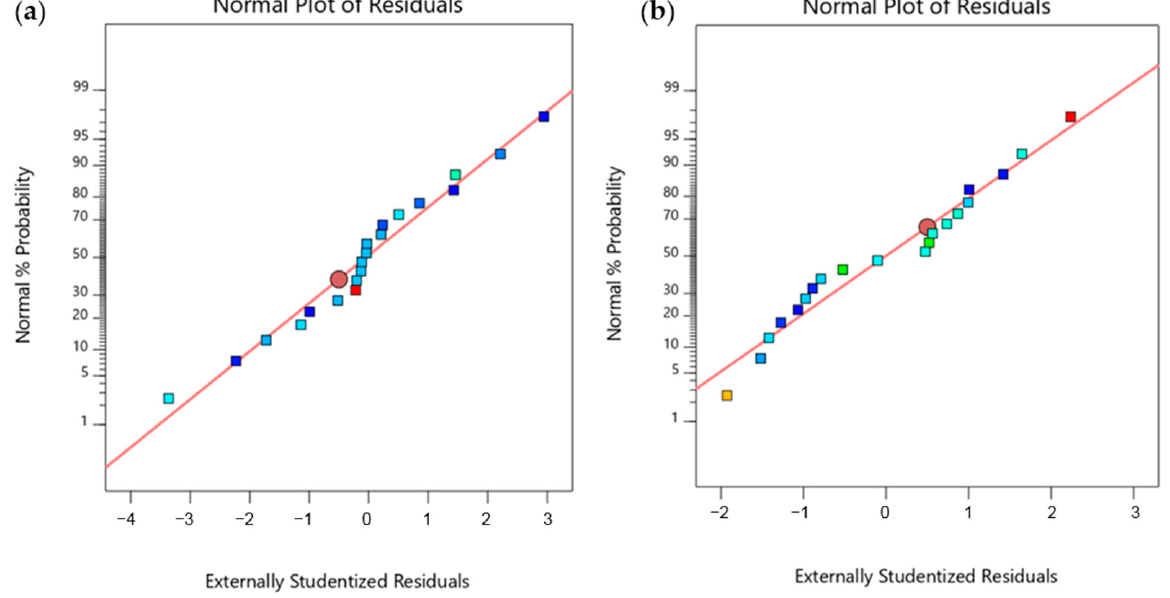
Figure 1. Normal plot of residuals for ( a ) picrocrocin and ( b ) crocins. The data acquired by the RCCD were generated into a response function quadratic model expressed by the coded equation (1) for picrocrocin, and (2) for crocins: Y1 = 0.9299 − 0.3066 A − 0.2216 B + 0.0474 C + 0.0863 AB + 0.0695 AC